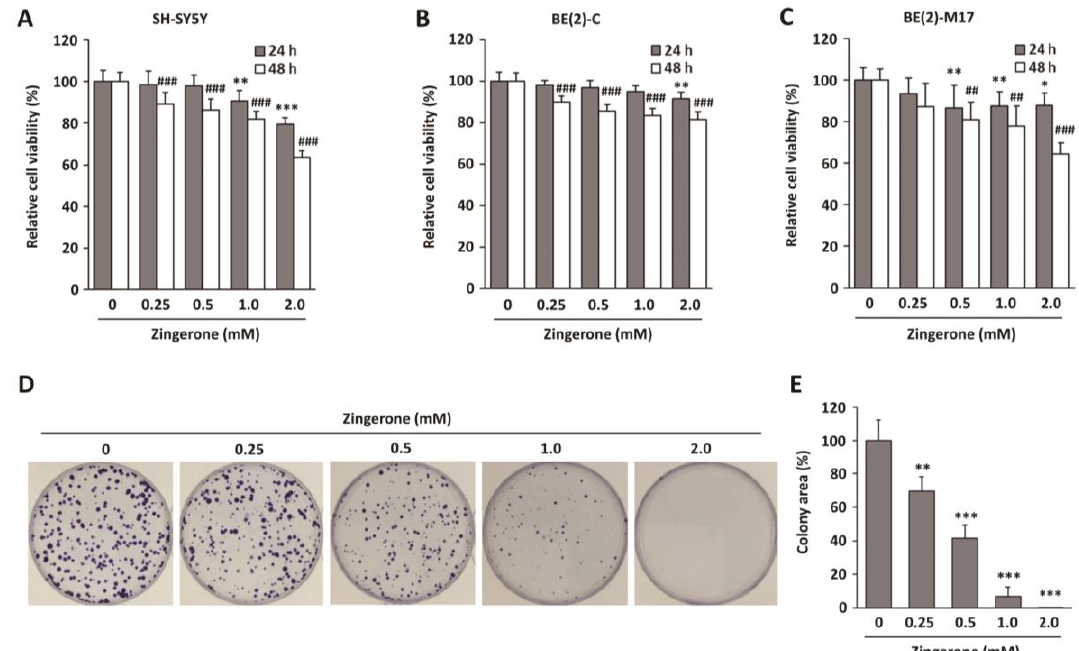
Figure 1. Effects of zingerone on viability of neuroblastoma cell lines. ( A ) SH-SY5Y, ( B ) BE(2)C, and ( C ) BE(2)-M17 cells were treated with zingerone for 24 and 48 h. Survival rate was determined using 3-(4,5-dimethylthiazol-2-yl)-2,5-diphenyltetrazolium bromide (MTT) assays. Data are presented as means ± standard deviation (SD) of the mean. All experiments were done three times independently. * p < 0.05; ** p < 0.01; and *** p < 0.001 vs. vehicle-treated control for 24 h. ## p < 0.01 and ### p < 0.001 vs. vehicle-treated control for 48 h. ( D ) Colony-formation assays of BE(2)-M17 cells treated with zingerone at the indicated concentration for two weeks. ( E ) Data analysis of colony area of ( D ). The data from three independent analyses are presented as the means ± SD of the mean. * p < 0.05; ** p < 0.01; and *** p < 0.001 vs. vehicle-treated